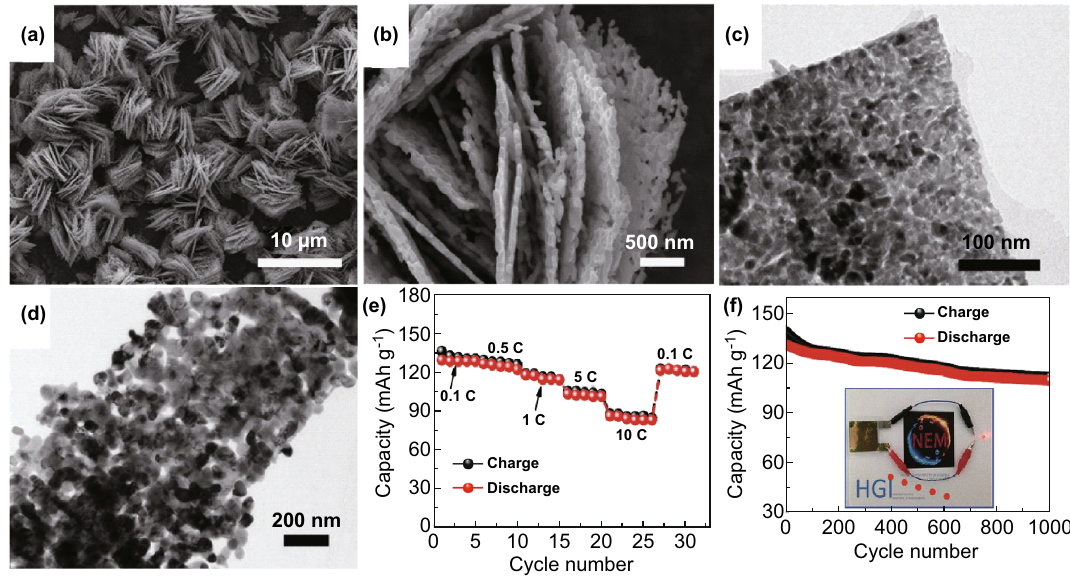
Fig. 9 3D architectures based on 2D nanoflake arrays on 3D skeleton ensembles for LIBs. a, b FESEM images of layered-LiCoO 2 nanoflake arrays. c TEM image of a single Co 3 O 4 nanoflake. d TEM image of a single-layered LiCoO 2 nanoflake. e Rate performance of LiCoO 2 // Li 4 Ti 5 O 12 full cell. f Cycle performance of LiCoO 2 //Li 4 Ti 5 O 12 full cell (inset photograph shows the full cell device lighting a LED). Reproduced with permission [104]. Copyright (cid:2) 2018, John Wiley & Sons,